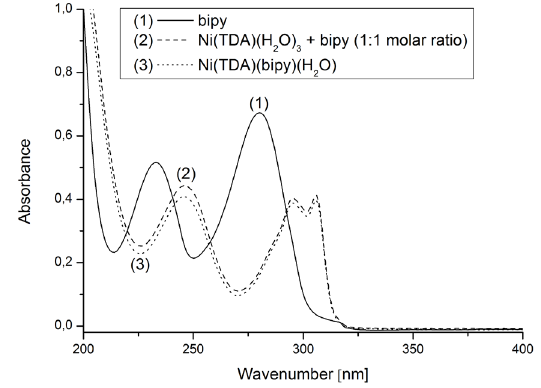
Figure 3 : Electronic spectra of the substrate 2,2’-bipyridine (bipy) (1), the mixture of bipy and Ni(TDA) in the molar ratio 1:1 (2) and the ternary complex Ni(TDA)(bipy)(H O) (3) in an aqua 2